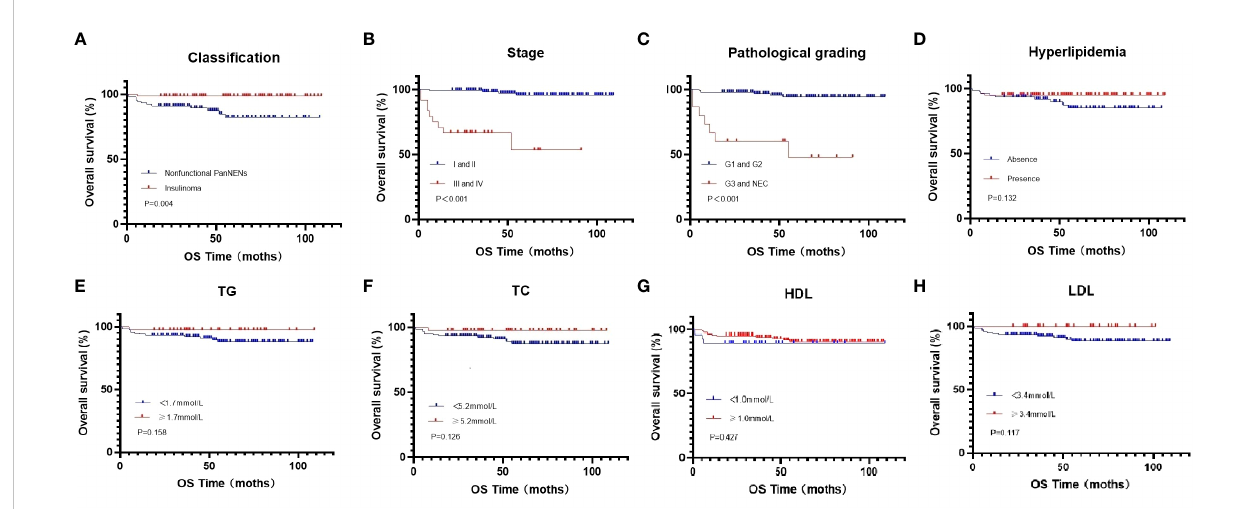
FIGURE 2 Kaplan-Meier curves for OS in all PanNENs patients (A) , regarding nonfunctional PanNENs vs insulinomas (P=0.004) (B) , regarding clinical phase clinical phase I and II vs clinical phase III and IV (P <0.001) (C) , regarding G1 and G2 vs G3 and NEC (P <0.001) (D) , regarding hyperlipidemia vs normal serum lipids (P =0.132) (E) , regarding low vs high TG levels (P =0.158) (F) , regarding low vs high TC levels (P =0.126) (G) , regarding low vs high HDL levels (P =0.427) (H) , regarding low vs high LDL levels (P